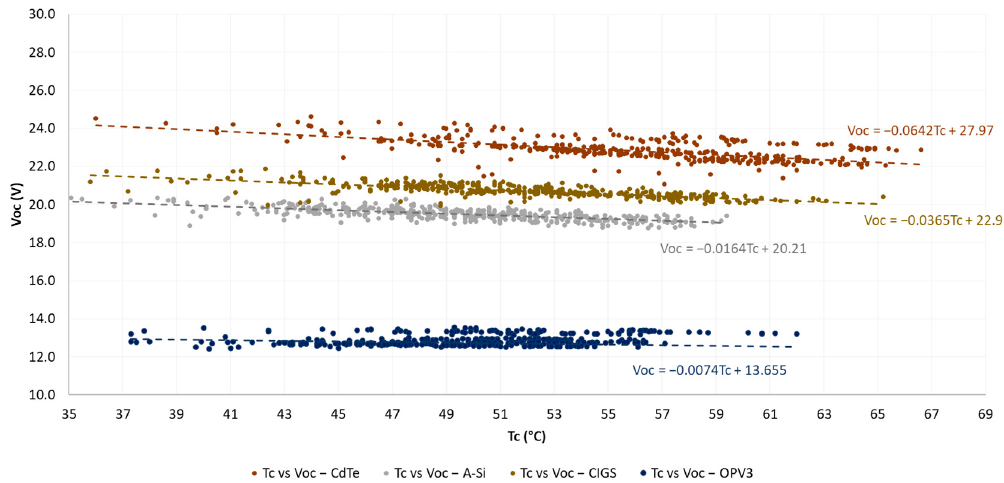
Figure 9. Voc vs. Tc at PVMS2 at Irr = 1000 ± 5 (W/m 2 ) during five months (Feb–Jun 2022).